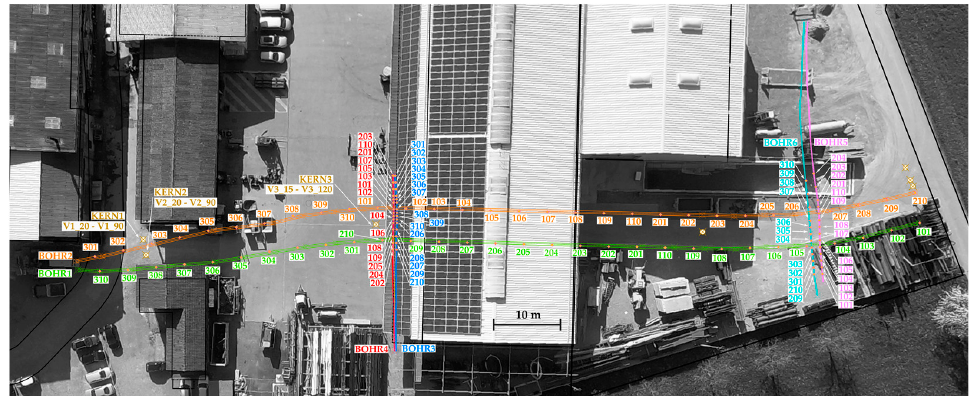
Figure 4. Layout of boreholes and temperature sensors installed on the property of Schenk AG. The heated borehole (BOHR2) ran parallel to the lengthwise measurement borehole (BOHR1) which allowed temperature measurements at different distances from the entry point to the ground for the entire 126 m. Sensors in BOHR2 were rendered invalid due to imprecise position in a region of sharp temperature gradients. Orthogonal boreholes KERN1–KERN3 enabled vertically oriented temperature measurements at specified dis- tances from the entry point to the ground. BOHR1 and BOHR2 required a sloped entry length whereby the drilled borehole was nearer to the surface than the target depth. Figure 5 below shows the underground profile of BOHR1, BOHR2, KERN1, KERN2, and KERN3 as they were drilled. Boreholes KERN1–KERN3 also include sensor IDs and location using